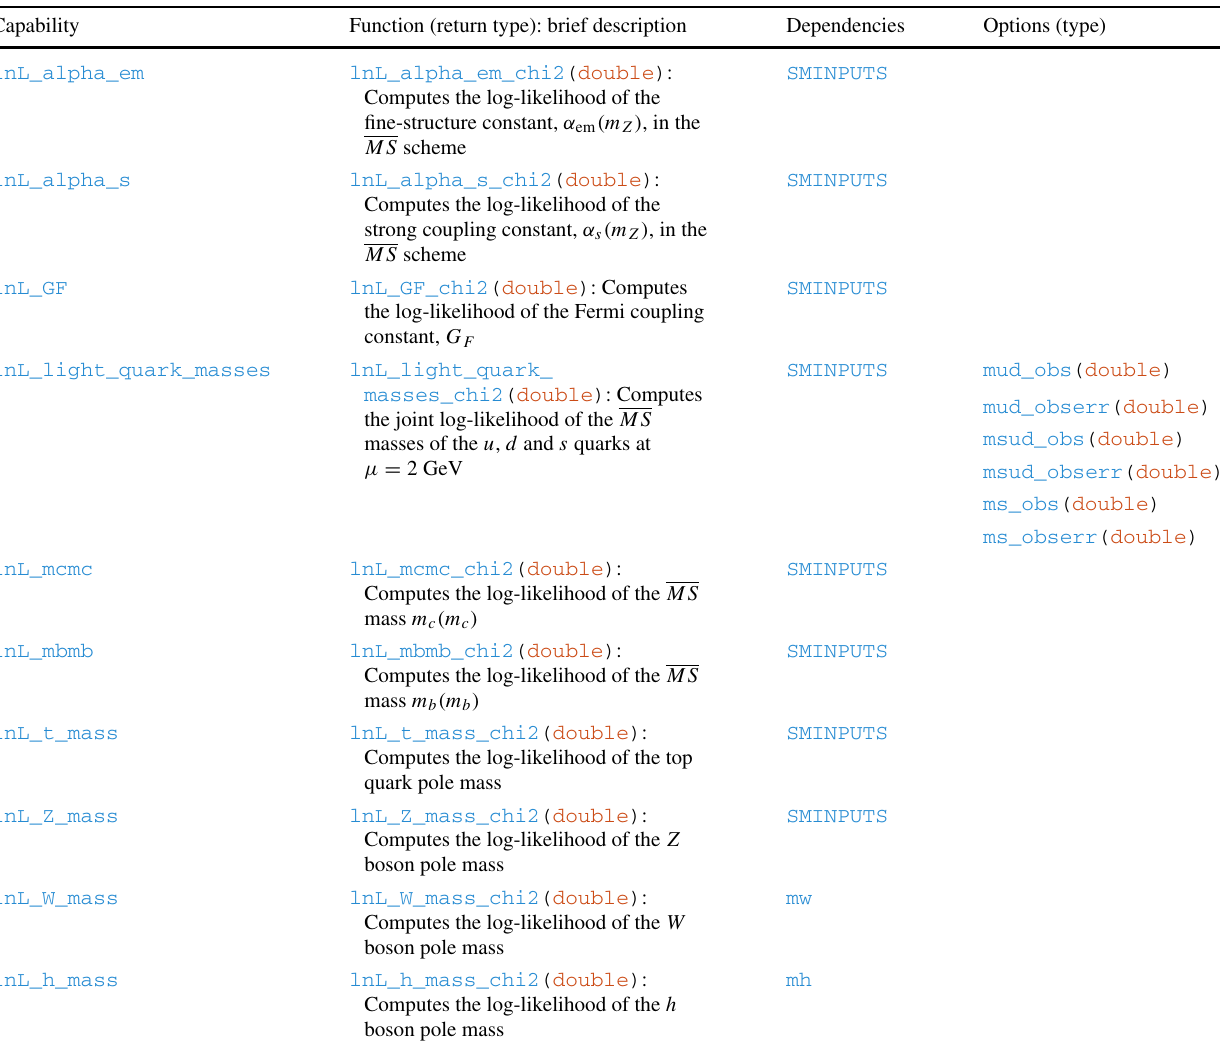
Table 8 PrecisionBit module functions providing log-likelihood cal- culations related to SM couplings and particle masses. All functions depend on SMINPUTS with the exception of the likelihoods of the W and h masses, which depend directly on the calculated W and h masses, respectively. These are available from both SM and BSM spec-